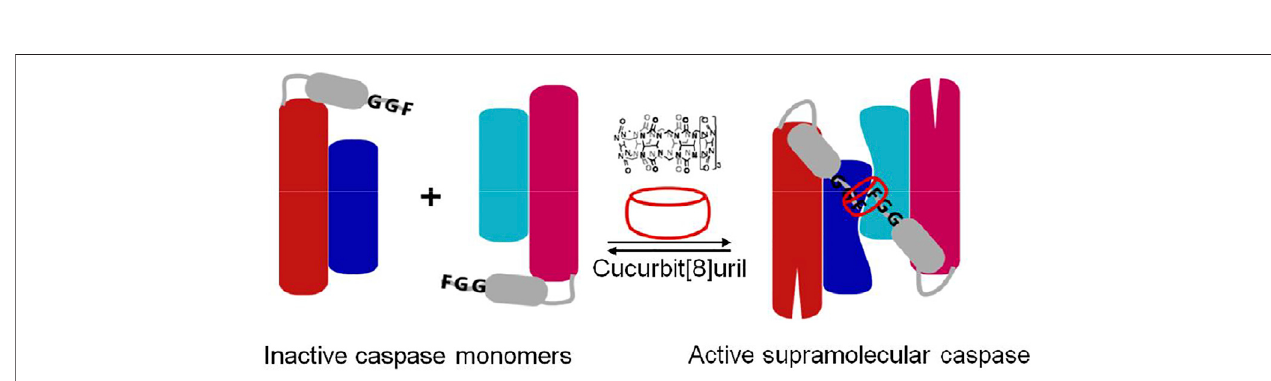
FIGURE 7 | Schematic representation of two yellow fl uorescent proteins having an N-terminal FGG peptide motif and their dimerization which is induced by cucurbit[8]uril (Nguyen et al., 2010).